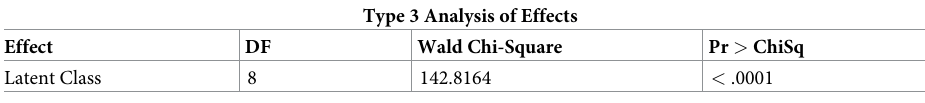
Table 5. Output for the five-class model without confounders.